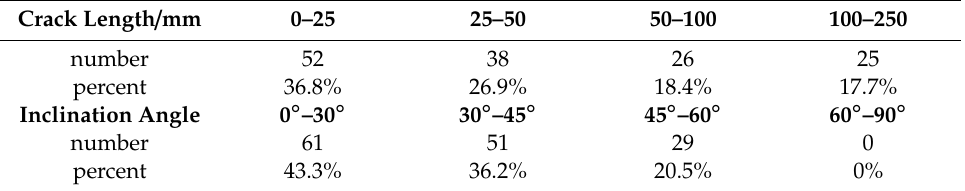
Table 1. Fatigue crack characteristics and quantity in cutouts.